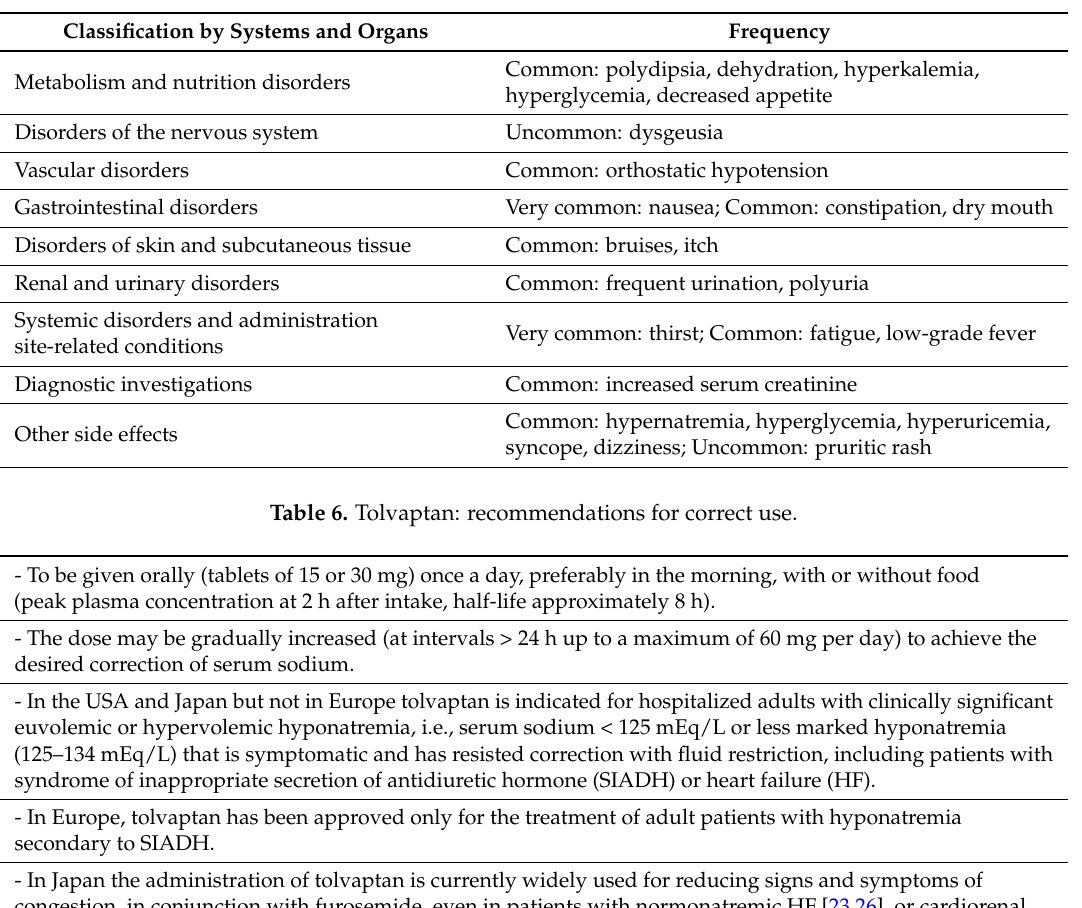
Table 5. Side-effects of tolvaptan.